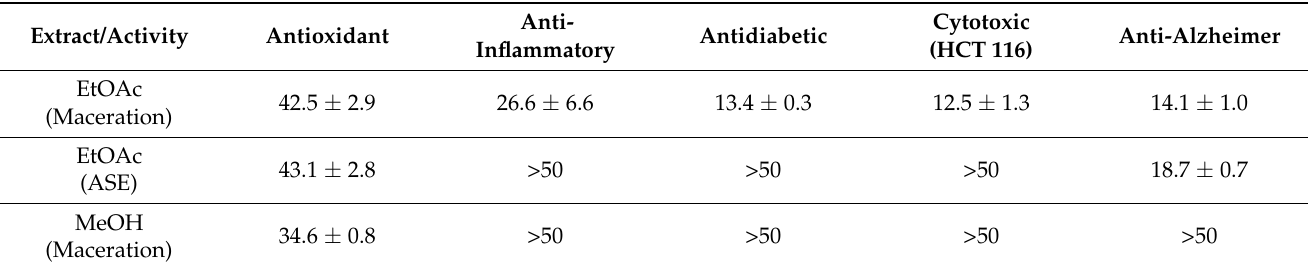
Figure 2. Antioxidant Activity of different extracts of V. vinifera stem (CYHA: Cyclohexane; DCM: Dichloromethane; EtOAc: Ethyl acetate; MeOH: Methanol; VIT C : ascorbic acid used as reference at 4µg/mL). Extracts were tested at 50 µg/mL. Means values ± SD ( n = 3); Different letter on the histograms means a significant difference ( p ≤ 0.05). Table 2. IC 50 values (µg/mL) of active extracts of V. vinifera Stem.